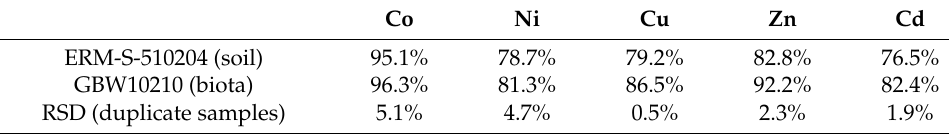
Table 1. Information about the QC